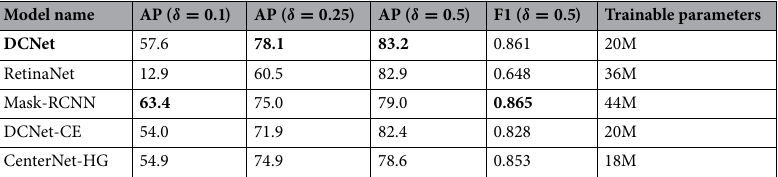
Table 2. Benchmark results and model sizes in identifying cell nuclei in the 2018 Kaggle Data Science Bowl dataset. The average precision (AP) of DCNet is compared against existing state of the art classifiers (RetinaNet 24 and Mask-RCNN 25 ) as well as two other key points networks variants of DCNet; DCNet semantic segmentation (DCNet-CE) and CenterNet hourglass network (CenterNet-HG). The AP for each model is reported across the percentage distance threshold values ( δ ) of 10%, 25% and 50% cell width, along with F1 score at 50% cell width. Higher AP/F1 score is better and bold figures indicates the best performing model for each threshold. The number of parameters ( M million) for each model is shown. Lower parameters is better with the number of parameters roughly proportional to time required for training the